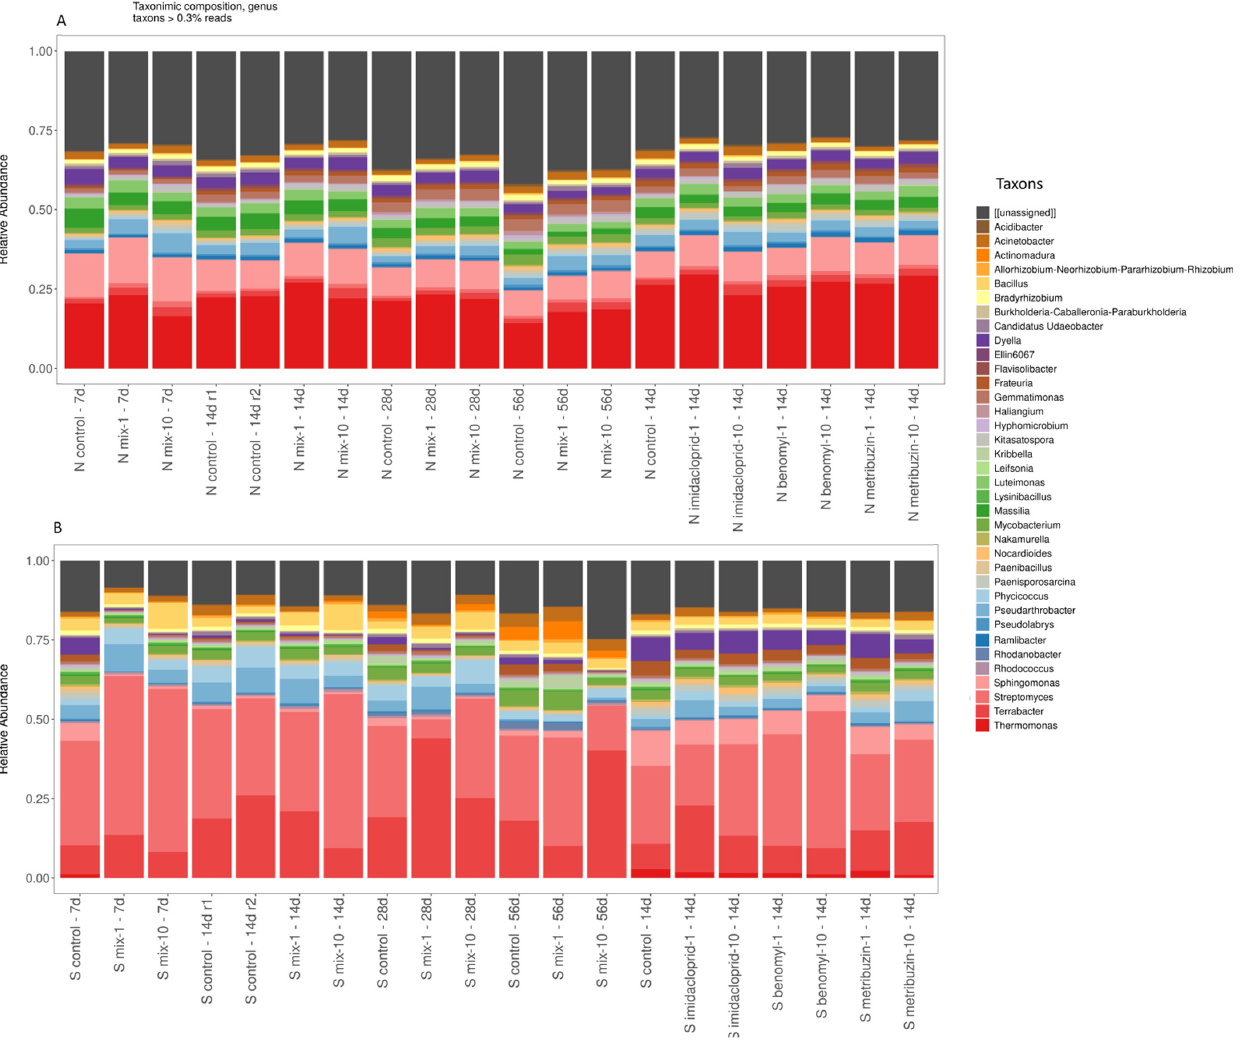
Figure 2. Bacteria’s genus in all variants of the experiments without SMM ( A ) and with SMM ( B ).